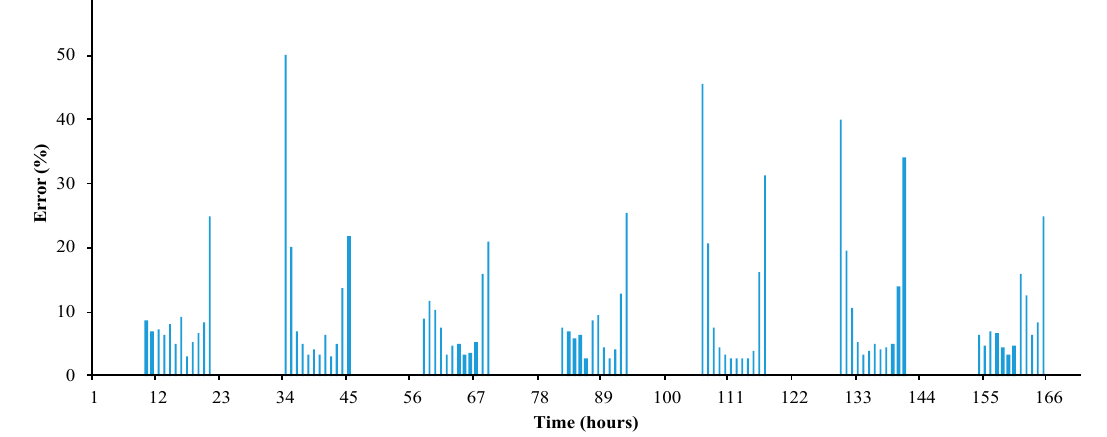
Figure 18. Weekly PV power output percentage error with ANFIS forecasting.